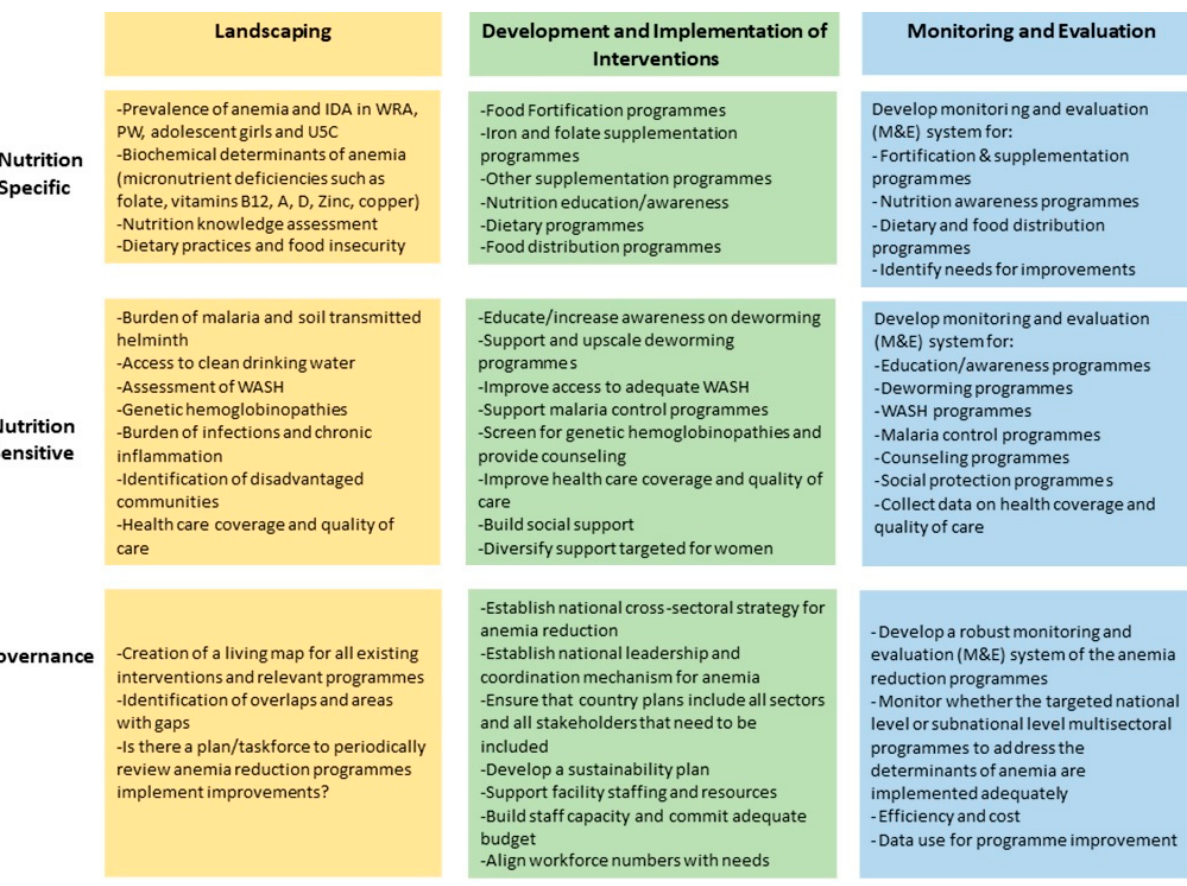
Figure 5. A framework for action for optimizing anemia reduction efforts in countries of the EMR. Abbreviations: EMR: Eastern Mediterranean Region; IDA: iron deficiency anemia; PW: pregnant women; U5C: underfive children; WASH: Water, Sanitation, and Hygiene; WRA: women of reproductive age.